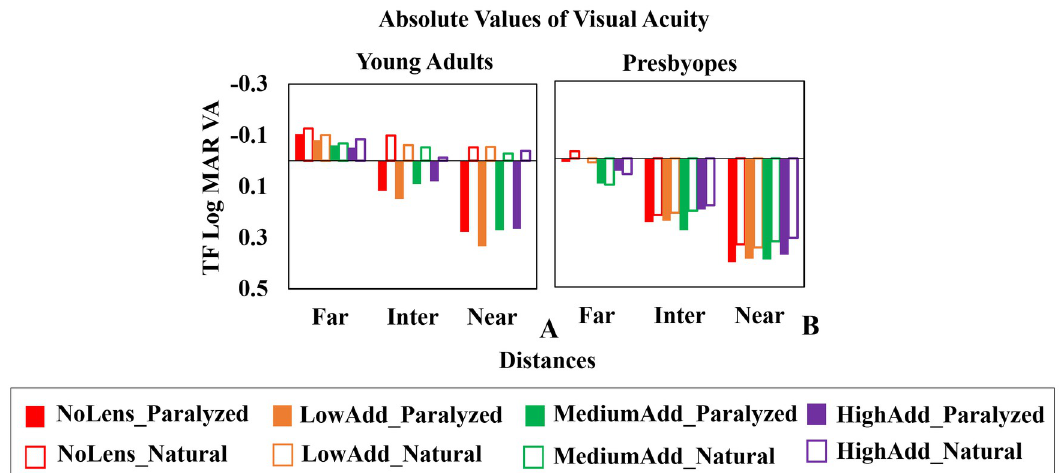
Fig 7. Average logMAR VA (across subjects) for far, intermediate, and near distances for both paralyzed accommodation and natural accommodation. (A) young adults. (B). presbyopes.–Red: NoLens; Orange: LowAdd; Green: MediumAdd; Purple: HighAdd; Solid bars: paralyzed accommodation; Open bars: natural